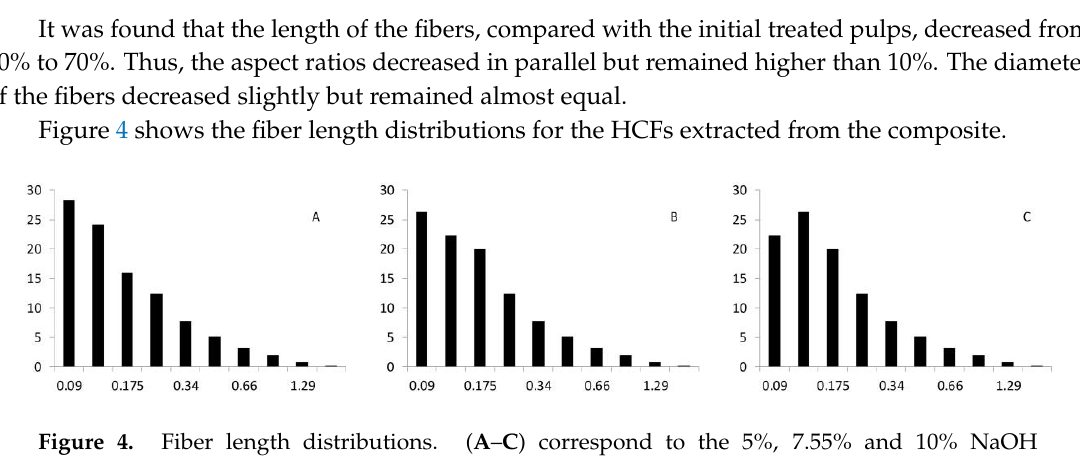
Table 4. Data used to solve the Kelly-Tyson modified equation with the method supplied by Bowyer and Bader.